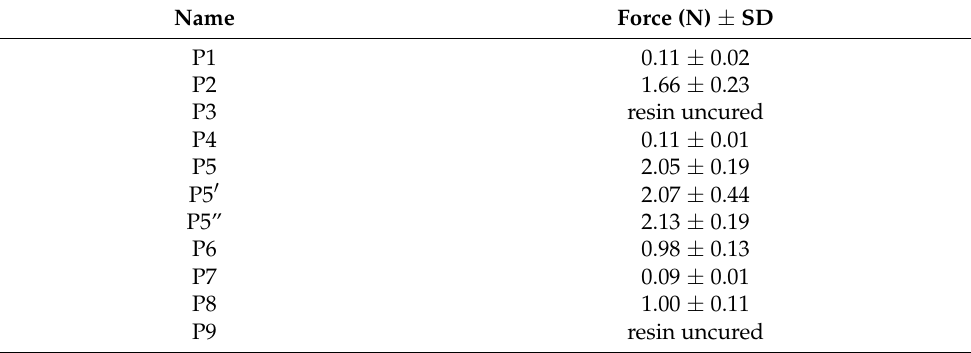
Figure 2. Examples of cured ( left side) and uncured ( right side) resins in blisters after 30 min of exposure to visible light and rinsing out the residual resin. Table 4. Mechanical properties of cured placebo resins, n = 5.